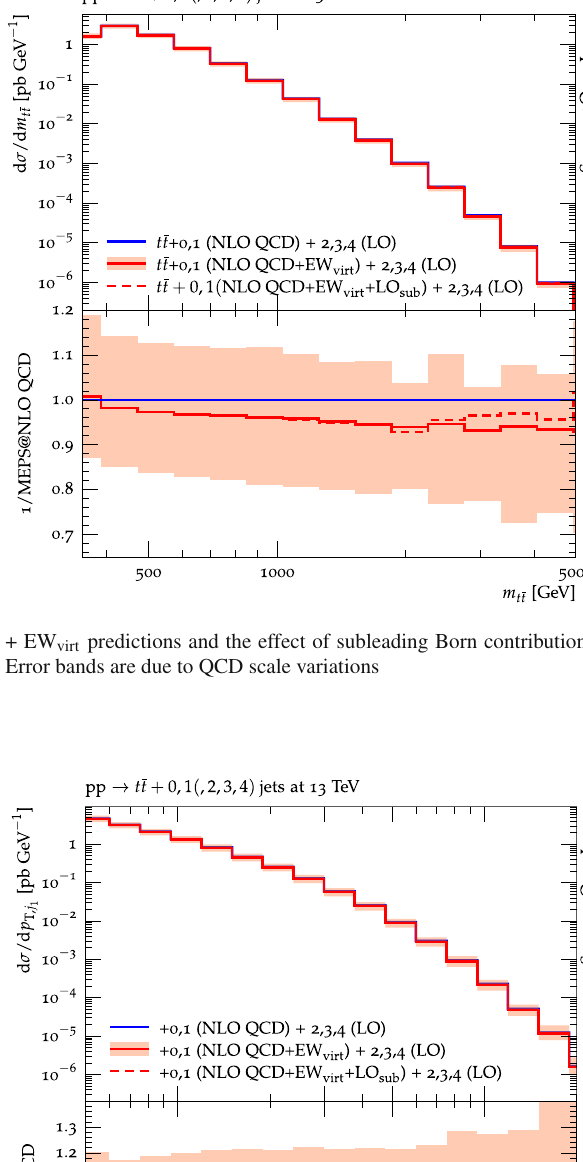
order results presented in Sect. 2. The same also holds for the effect of the subleading Born